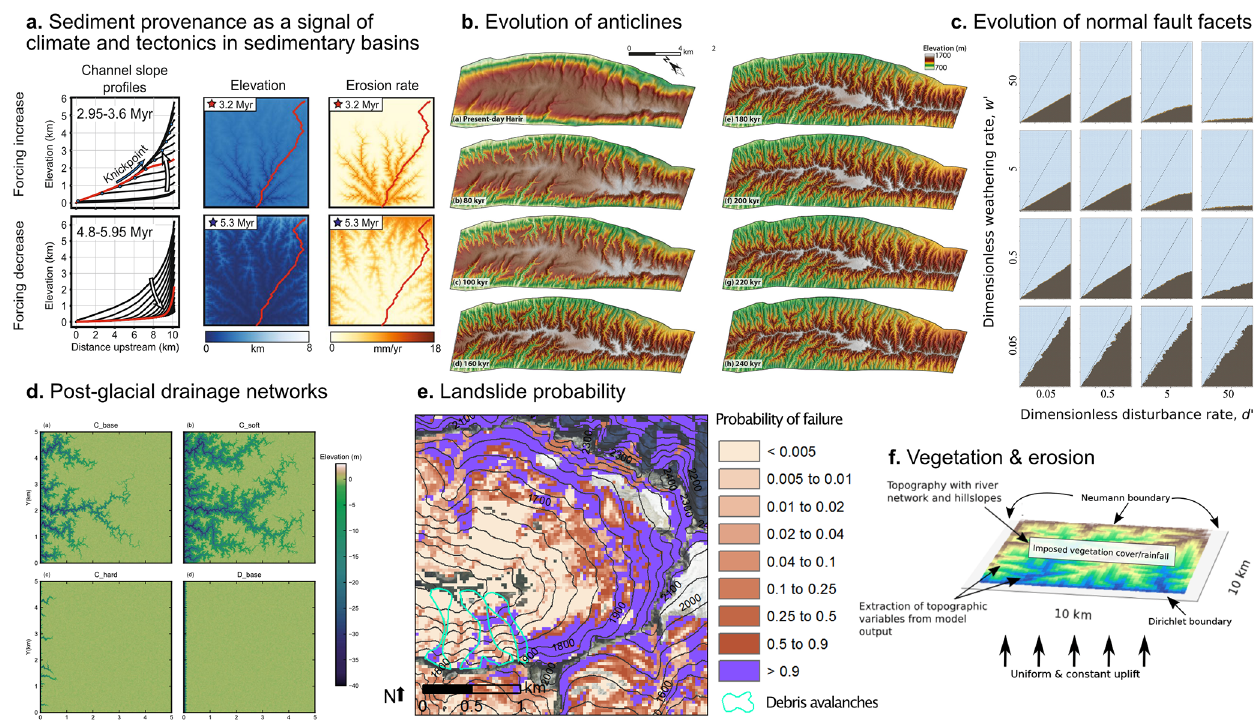
Figure 1. Examples of modeling applications implemented with Landlab span a wide range of timescales and topics. A recent selection of examples intended to highlight diversity of applications includes the following examples: (a) sediment provenance studies (Sharman et al., 2019, reproduction modified from their Fig. 2), (b) landscape evolution of anticlines (Zebari et al., 2019, reproduction of their Fig. 8), (c) cel- lular automaton simulation of normal fault facets (Tucker et al., 2020, reproduction of their Fig. 9), (d) the evolution of post-glacial drainage networks (Lai and Anders, 2018, reproduction of their Fig. 4), (e) estimates of landslide probability (Strauch et al., 2018, reproduction modified from their Fig. 9), (f) and coevolution of vegetation and erosion (Schmid et al., 2018, reproduction of their Fig. 3). All subpanels except (d) covered by CC BY license. Permission to reproduce (d) was obtained through Copyright Clearance Center